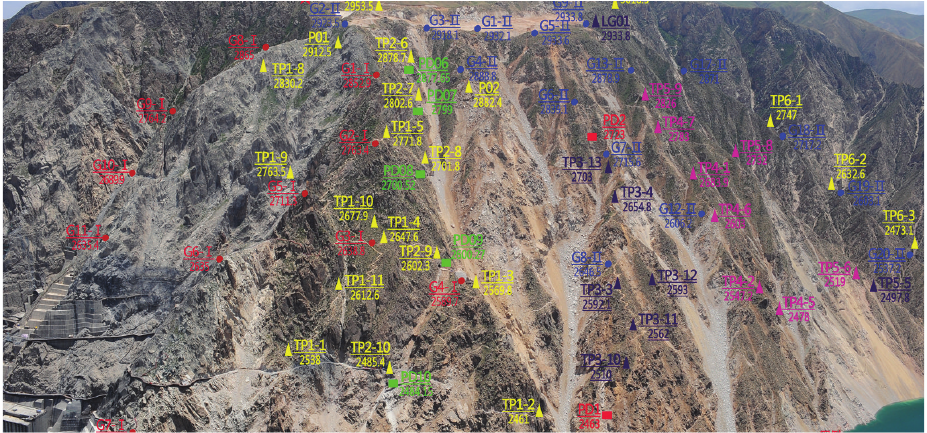
Figure 1: Arrangement of the surface